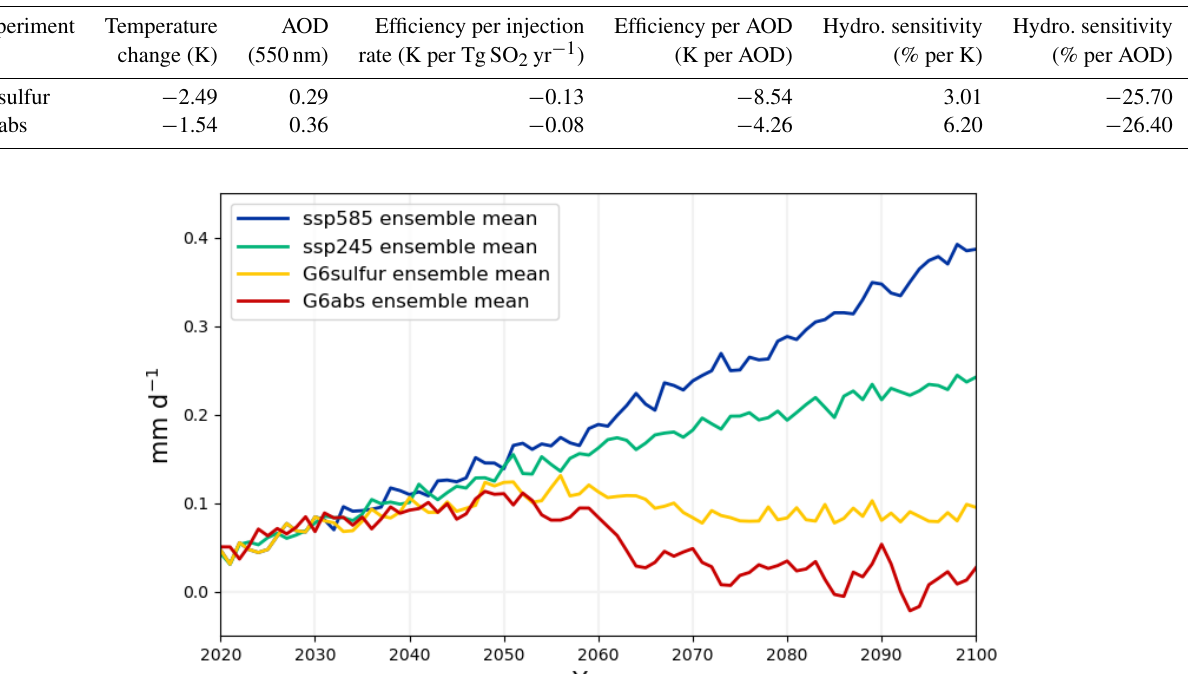
Figure 3. The mean change in the global-mean precipitation from PI conditions for the SSP5–8.5 (ssp585), SSP2–4.55 (ssp245), G6sulfur and G6abs ensembles. Each ensemble is comprised of three